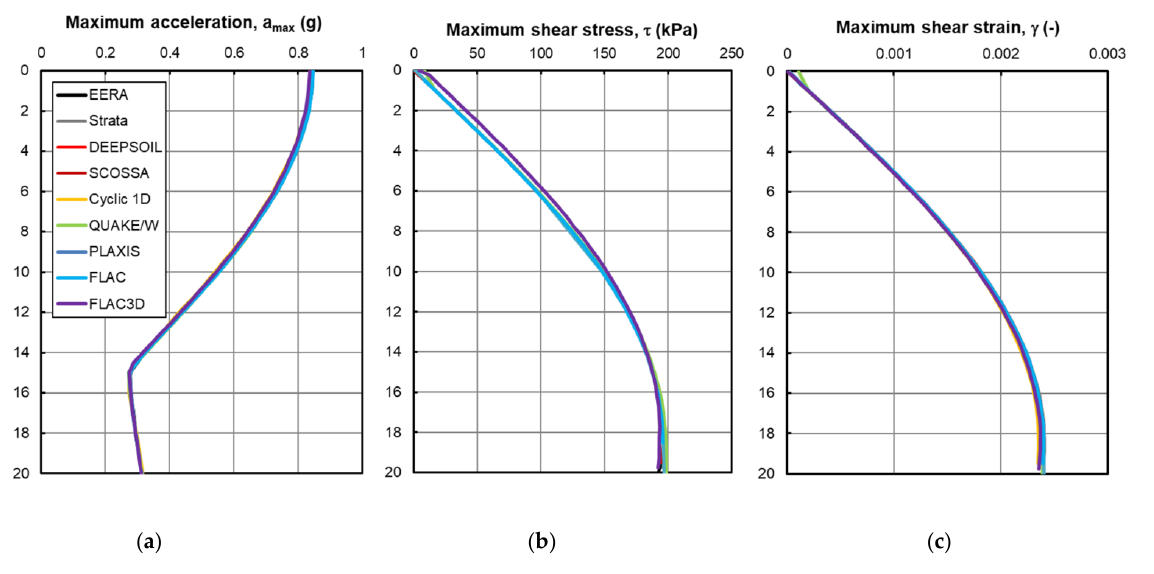
Figure 5. Vertical profiles of the maximum acceleration ( a ), shear stress ( b ), and shear strain ( c ) deriving from the analyzes carried out with the nine considered codes.